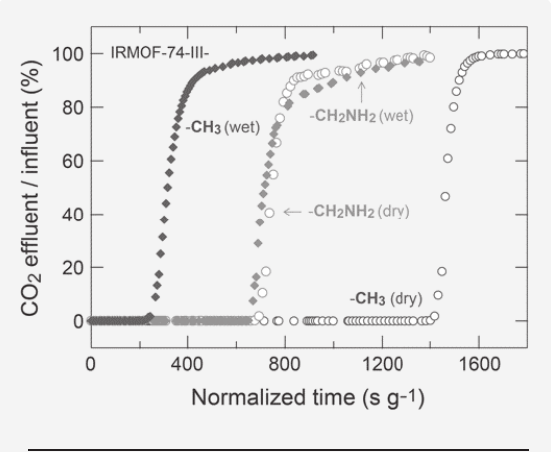
Fig. 5a. Crystal structure of MOF-801 with a cube of 8 water mol- ecules shown in the pores that act as seeds for further uptake of water from